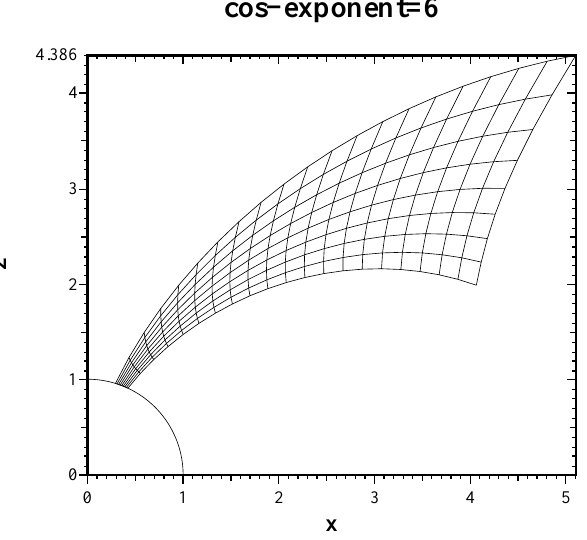
Fig. 13. The (χ,θ i ) coordinate grid in ϕ i = 0 sector with cos 6 θ i correction factor in the definition of χ . χ varies between 0 and 0 .